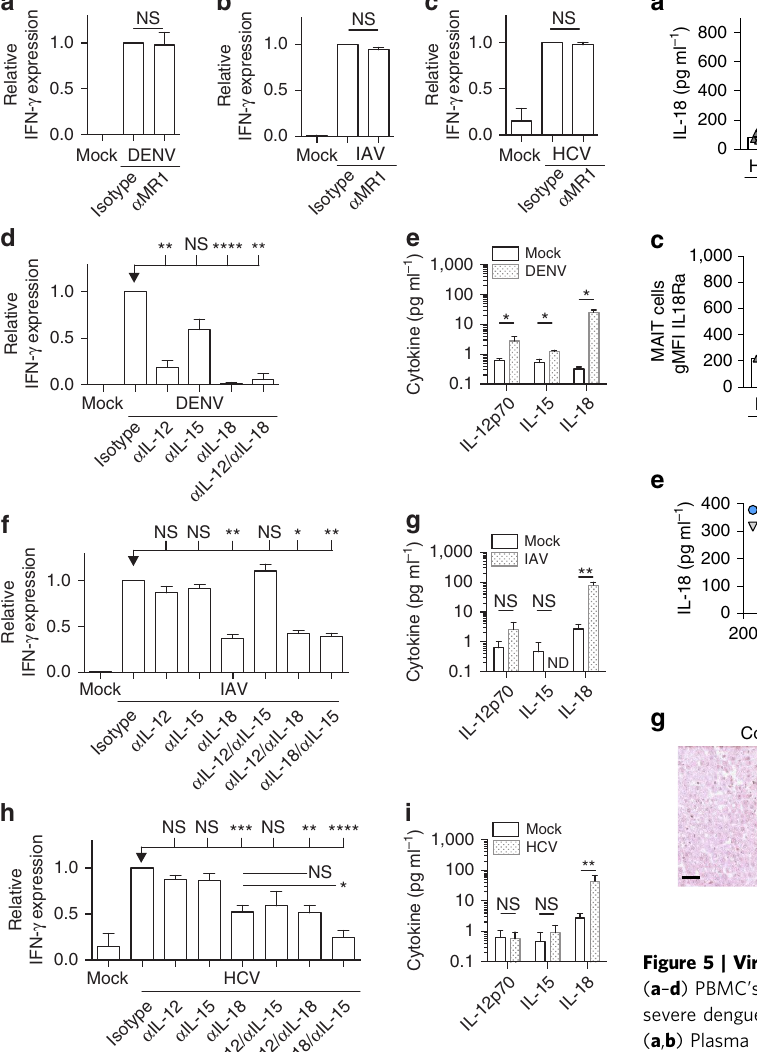
Figure 4 | Viral MAITcell activation is dependent on cytokines. ( a – d , f , h ) Isotype control, anti-MR1, anti-IL-12, anti-IL-15 and/or anti-IL-18 antibodies were added to a co-culture exposed to DENV ( a , d , n ¼ 3–6), IAV ( b , f , n ¼ 5–